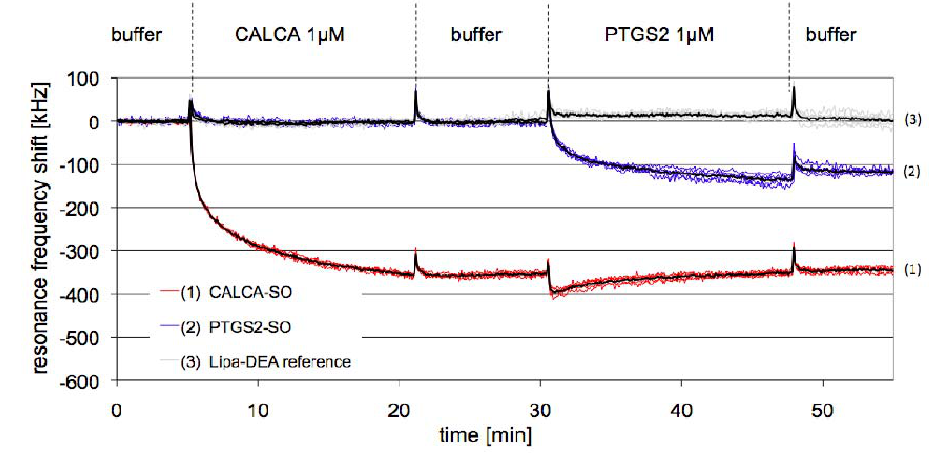
Figure 4. The frequency response of selected pixels of one FBAR chip: The red curves correspond to surfaces functionalized with S-S-CALCA/Lipa-DEA, the blue curves to surfaces functionalized with S-S-PTGS2/Lipa-DEA and the grey curves to surfaces passivated with Lipa-DEA only. The number of replicas is 5 for each type of functionalisation; the black curves are the average of the 5